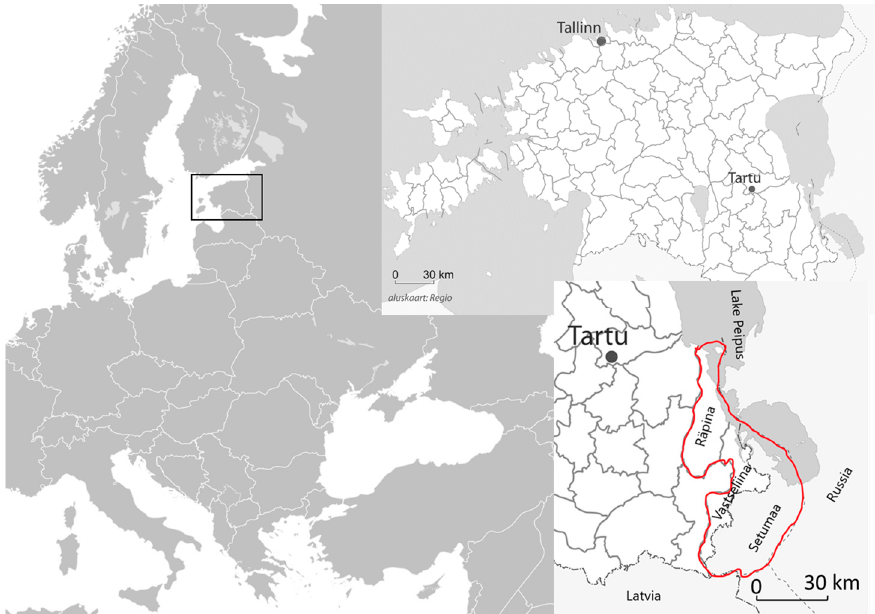
Figure 1. Map of the